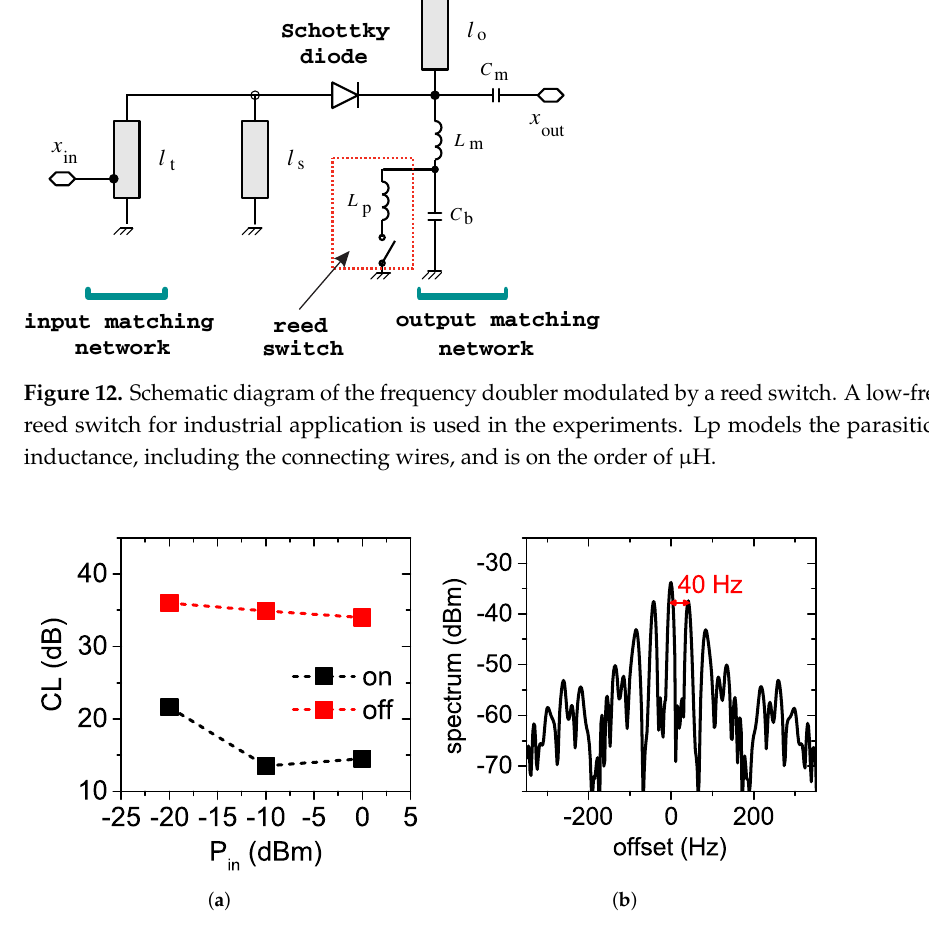
Figure 13. Measured results of the frequency doubler modulated by a reed switch. ( a ) Conversion loss of the doubler with the reed switch in on and of configuration. ( b ) Output spectrum of the doubler in the dynamic